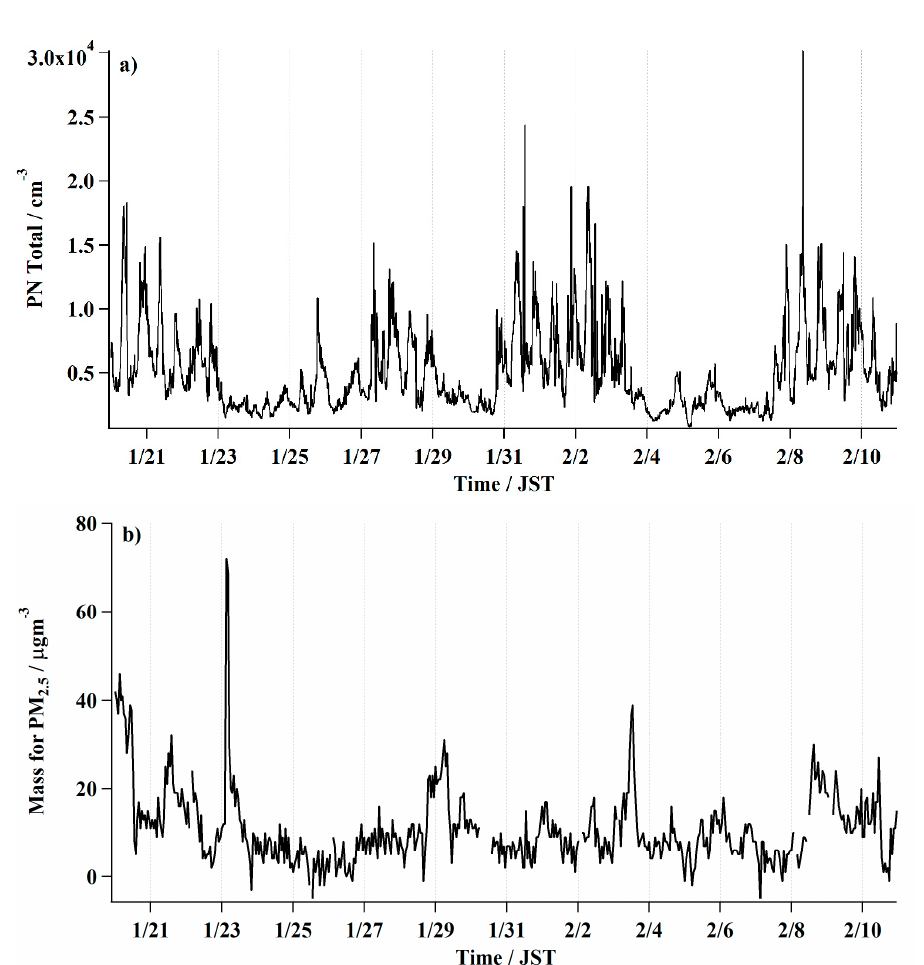
Figure 4. ( a ) Total particle number and ( b ) PM 2.5 mass concentration.